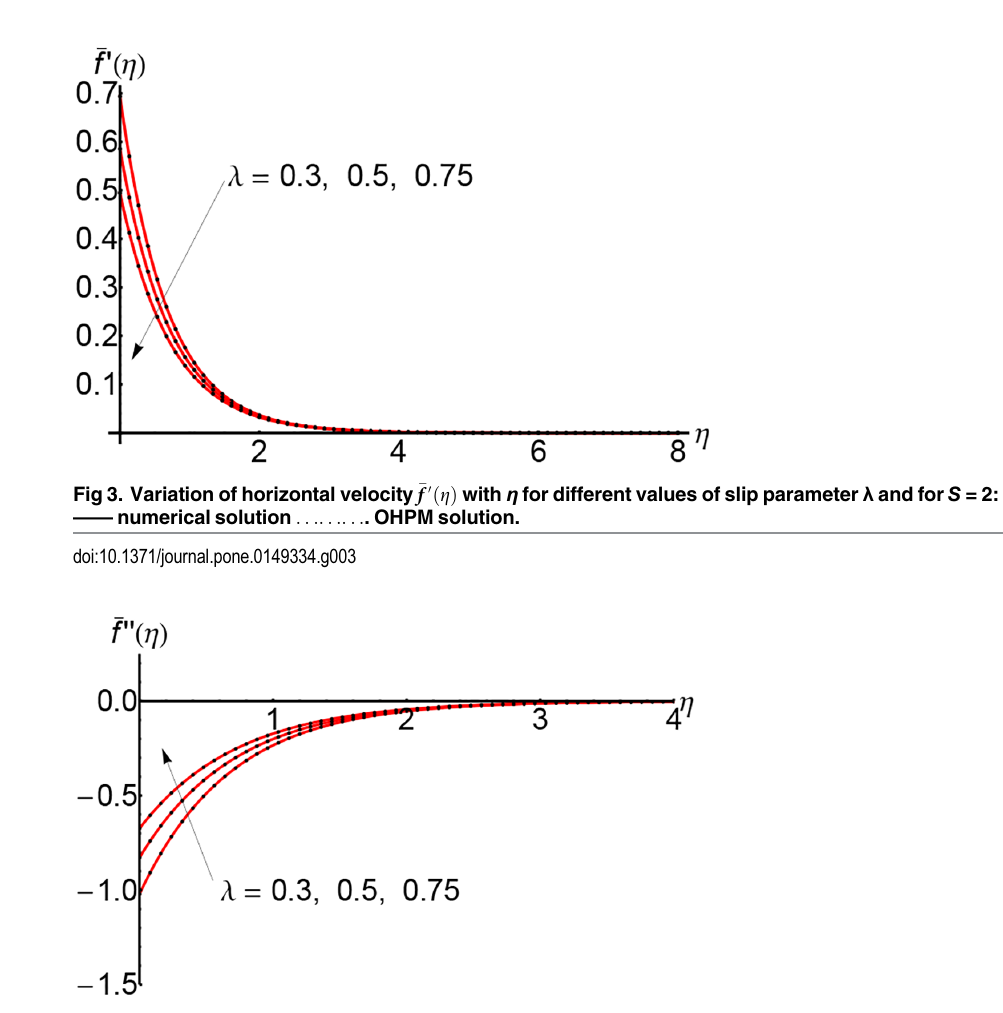
Fig 4. Variation of shear stress (cid:2) f 00 ð Z Þ with η for different values of slip parameter λ : —— numerical solution ......... . OHPM solution.